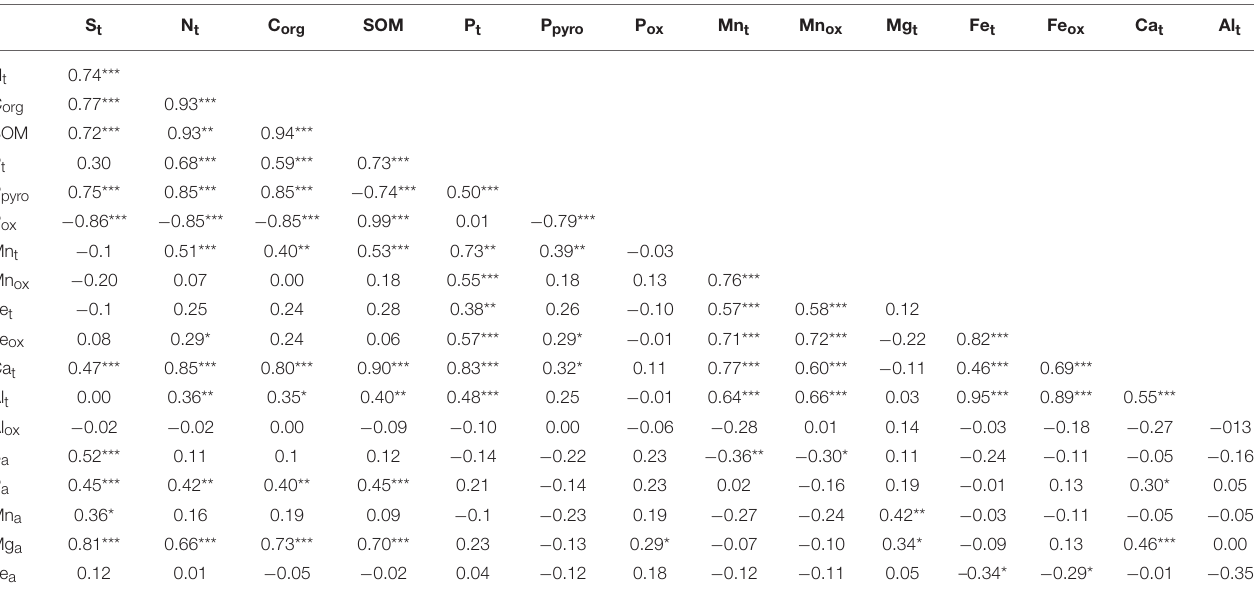
TABLE 6 | Pearson correlation coefficients among soil organic matter, selected available plant nutrients and total element concentrations in surface soil of a rewetted